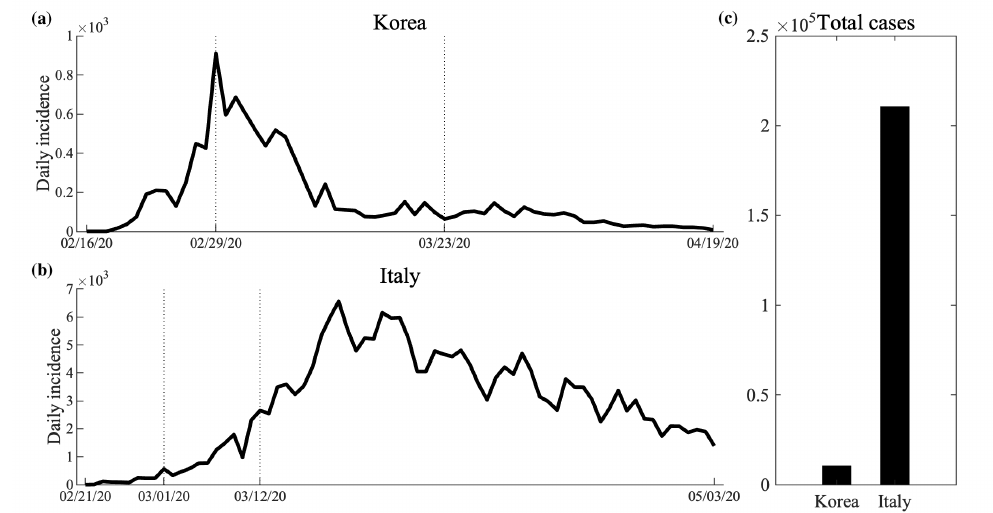
Figure 1. Confirmed cases during the first outbreak of COVID-19 in Korea and Italy: ( a ) daily confirmed cases in Korea (16 February 2020 ∼ 19 April 2020); ( b ) daily confirmed cases in Italy (21 February 2020 ∼ 5 March 2020); ( c ) cumulative confirmed cases in Korea and Italy at the end of the simulation period.